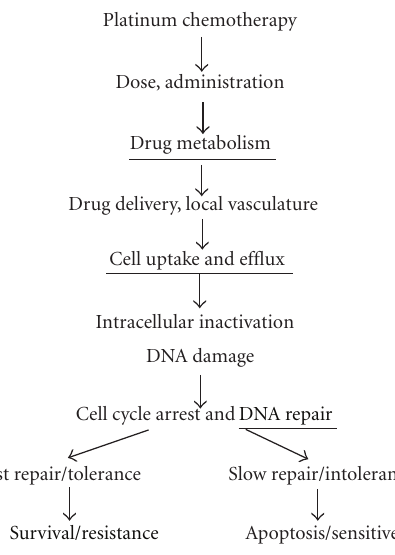
Figure 1: Pathways leading to chemotherapy-induced cell death and resistance. The major steps are shown in the sequential